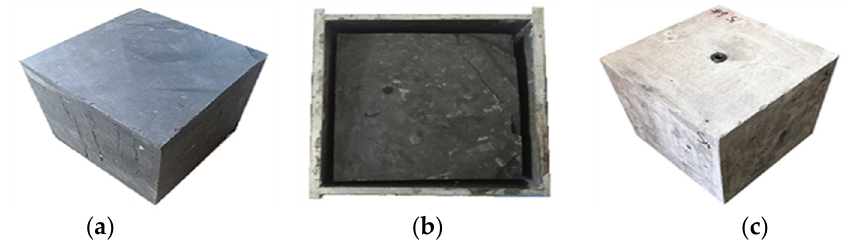
Figure 2. Coal sample before and after casting: ( a ) coal sample before casting; ( b ) the mold; ( c ) coal sample after casting.